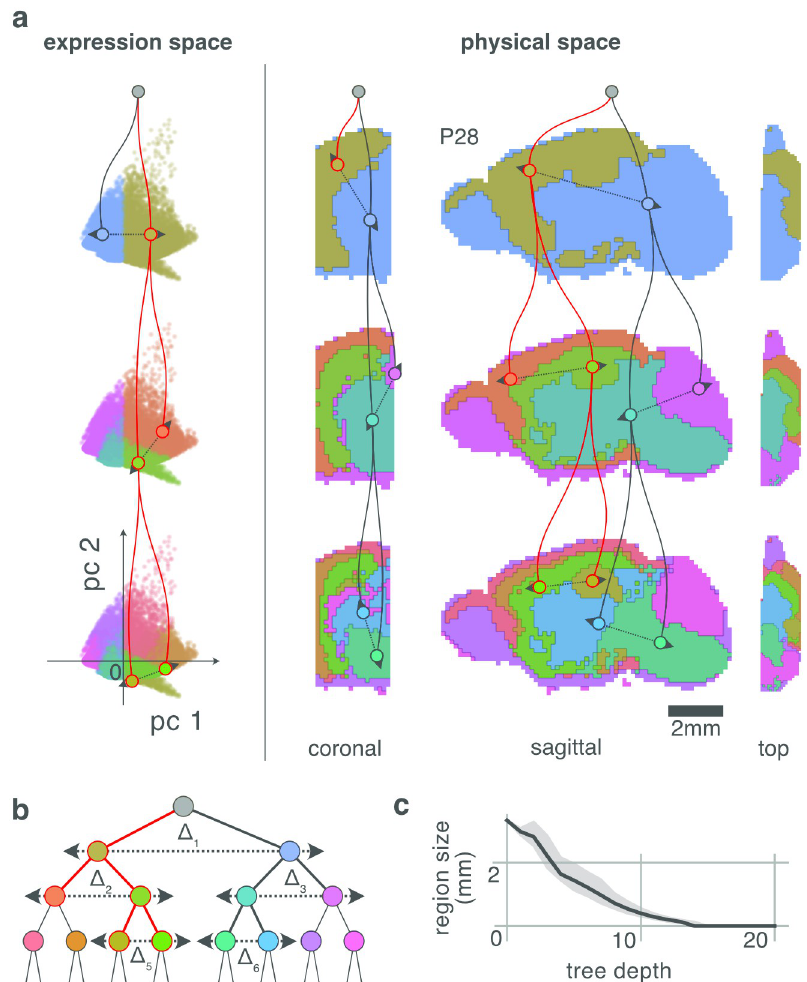
Fig 5. Hierarchical decomposition of covariance in gene expression space brain is mirrored by a matching decomposition in brain space. Here the results are for postnatal (P) day 28. The results from further time points can be found in S3–S10 Figs. A Expression Hierarchical decomposition on the collection of voxels in expression space, independent of source location in brain. Decomposition is performed by measuring the first principal component of covariance; then sorting all voxels into two bins, (competing bins indicated by dotted arrows) based on their individual projection coefficients. This process is repeated recursively on each of the resulting bins, until a bin contains only a single voxel remains (Figure shows only the first 3 generations of the resulting hierarchy). Physical Space Same voxel bins and coloring, but voxels now positioned at their source locations in brain. Coronal and horizontal sections are shown: the color of each pixel indicates the most common bin in the occluded direction for that pixel. Horizontal section (labeled top) is drawn at a smaller scale. Multiscale spatially coherent covariance patterns are present. Two example branches of the hierarchy are indicated with red and black curves. B Hierarchy of bins of the hierarchical decomposition. The bins are colored to represent the hierarchy: the parent bin has the average hue of the child bins. This coloring is applied throughout the paper. C Although regions are nested by construction (hierarchical decomposition), we quantified the extent to which the regions are also continuous by measuring their spatial spread (average distance from the region centroid) as a function of their depth in the hierarchy. At the root of the hierarchy the spatial spread covers the entire brain, and we expect that as the depth increases the spatial spread (i.e., the mean distance from the region centroid to the constituent voxels) decreases. To make the different time points and simulation comparable we present the spreads as a fraction of the root spread. The solid line indicates the median spread over all regions at that depth, and the gray area the first (below) and third (above) quartiles. As expected, the mean distance from the centroid decreases as the regions become more resolved with depth.